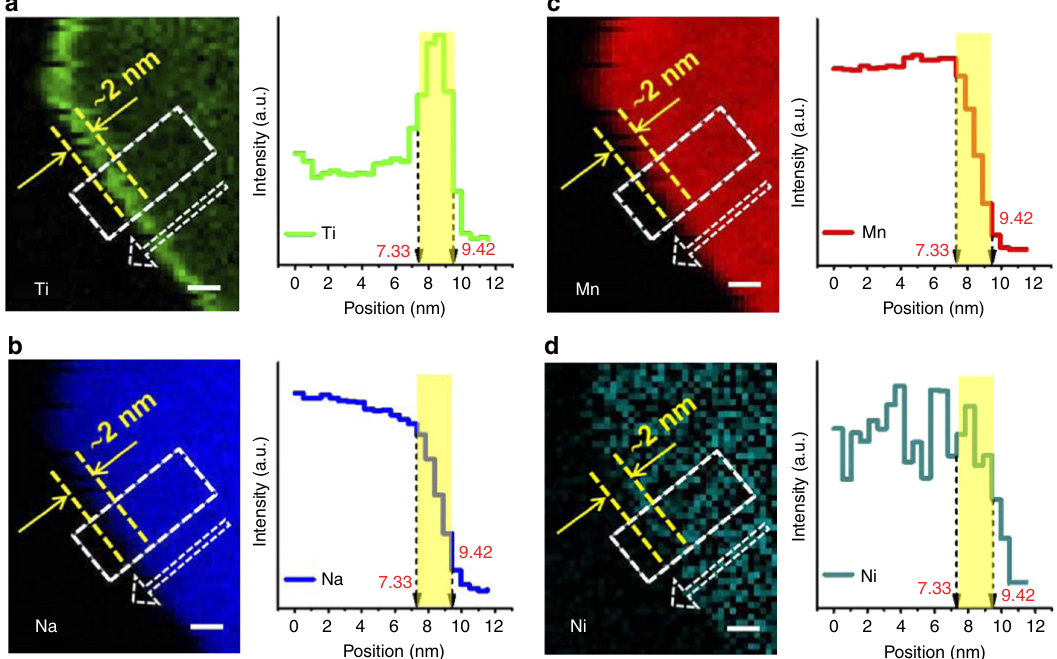
Fig. 1 Titanium surface segregation. EELS chemical mapping of the NMTN samples and corresponding chemical compositions ( white rectangle ) for a Ti, b Na, c Mn, and d Ni elements. The yellow dotted lines and vertical shadings indicate the location of the interface. The results show that the interface 2 nm from the particle edge is enriched by titanium rather than other elements. Scale bar, 2